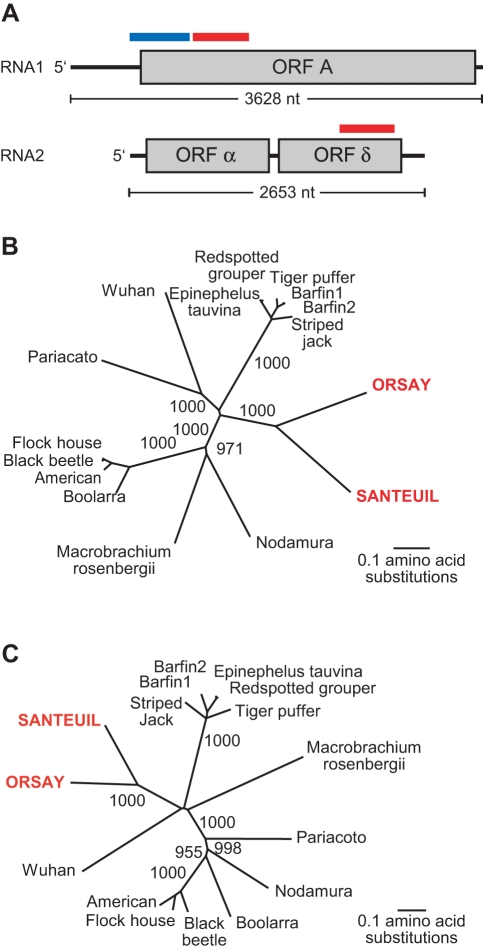
Genomic organization and phylogenetic analysis of novel viruses.(A) Schematic of genomic organization of Santeuil virus. Predicted open reading frames are displayed in gray boxes. Red bar indicates sequence used to generate double-stranded DNA probes for Northern blotting. Blue bar indicates sequence used to generate single-stranded riboprobes. (B) Neighbor-joining phylogenetic analysis of the predicted RNA-dependent RNA polymerases encoded by the RNA1 segments. (C) Neighbor-joining phylogenetic analysis of the predicted capsid proteins encoded by the RNA2 segments.